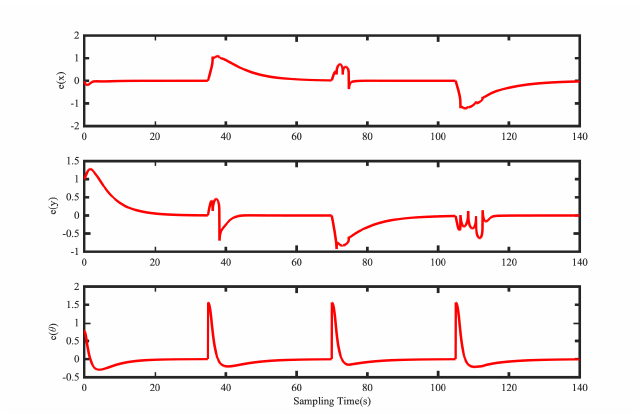
Figure 10. The state errors of the biomimetic spherical robot-Case II.